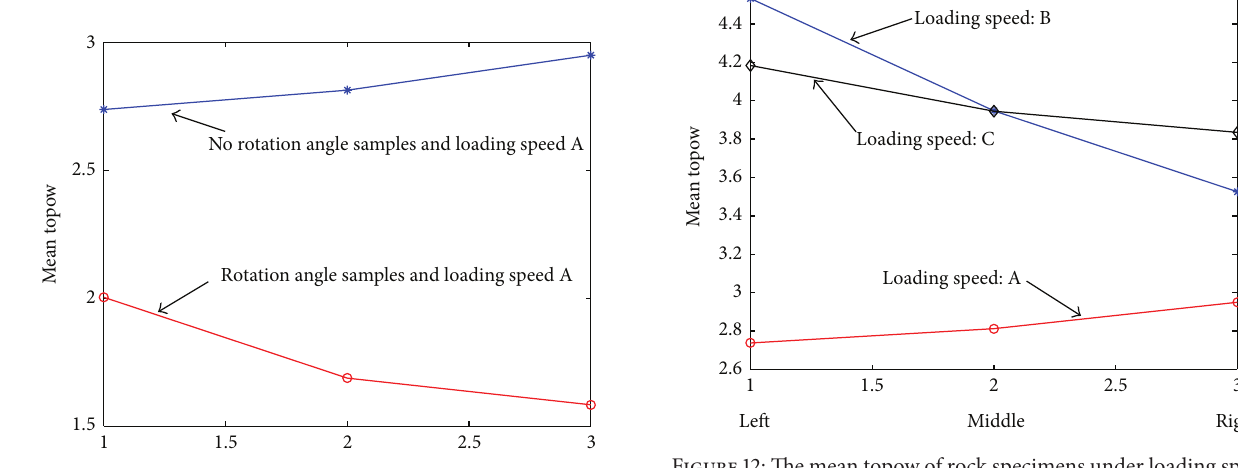
Figure 12: The mean topow of rock specimens under loading speed A, B,